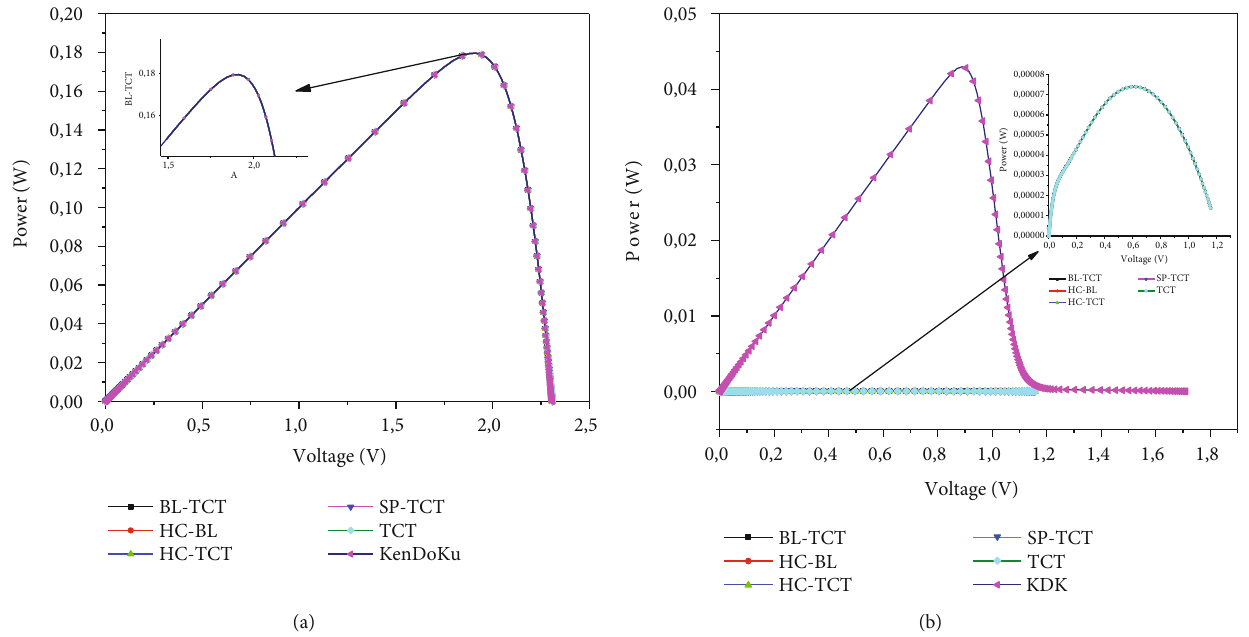
Figure 12: P-V characteristics of various PV module topologies operating in (a) FS-pattern and (b) VS-pattern.